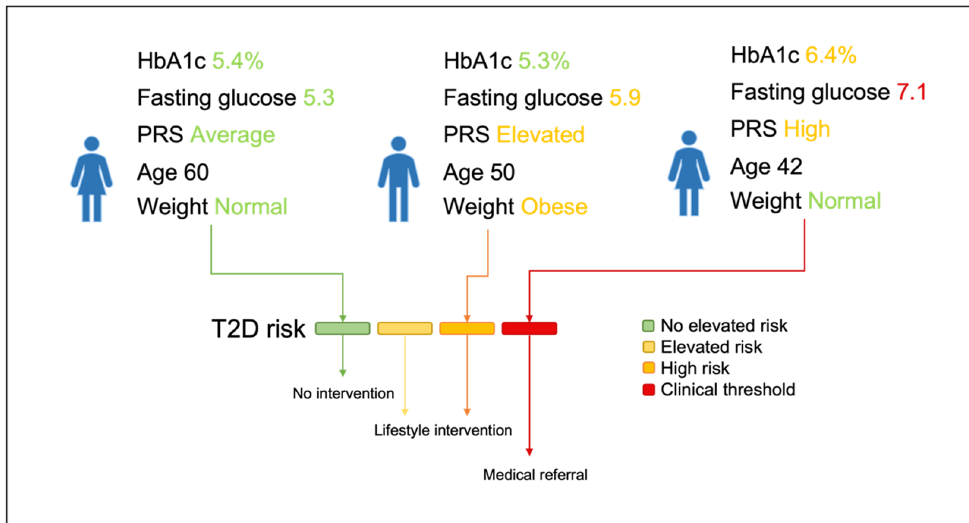
Figure 1. Schematic overview of how individuals are classified according to the rules models into four risk categories. Those without any (bio)markers, including genetic scores and physical measurements, are not at elevated risk; those with a specific set of literature-based risk factors as detailed in Table S2 are at high risk; others with markers outside of normal range but without decisively high risk factors, are at elevated risk. When a marker such as glucose crosses the clinical threshold, participants would no longer be recommended lifestyle intervention. HbA1c = glycated hemoglobin, PRS = polygenic risk score, T2D = diabetes type 2.